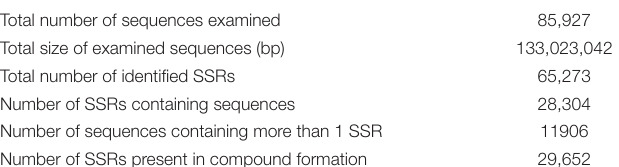
TABLE 3 | Statistics of SSRs identified from P. amarus leaf transcriptome.